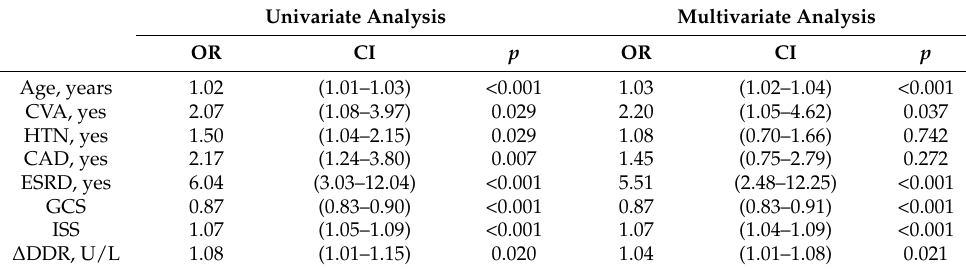
Table 3. Univariate and multivariate analysis of the risk factors for mortality of the patients.